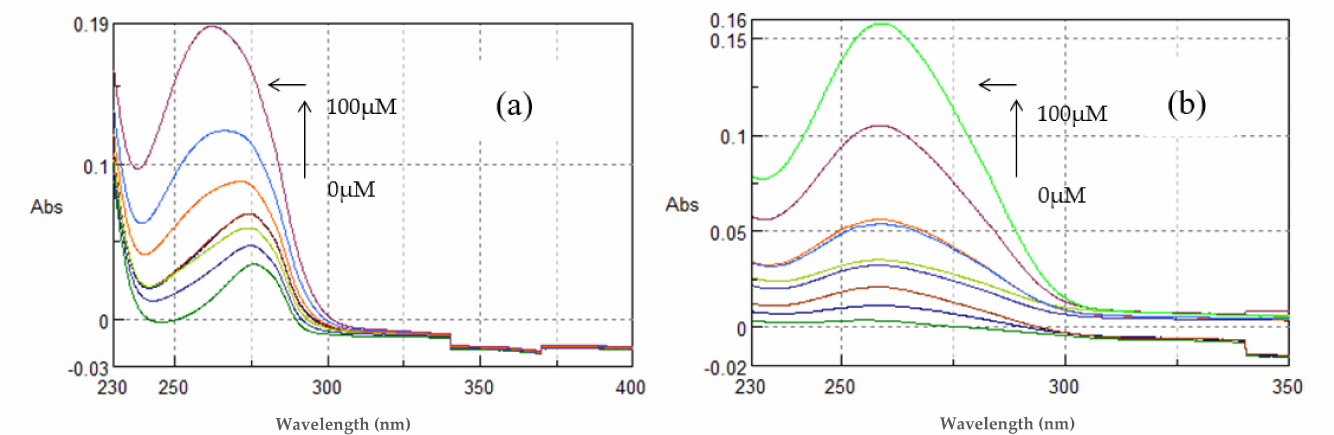
Figure 14. Absorption spectra of ( a ) TYR- β CD and ( b ) TYR- β CD/CS (100 µ M, pH 7.4) in Tris-HCl buffer with increasing concentrations of ctDNA (0–100 µ M). Arrows ( ) and ( ) refer to hyperchromic and hypsochromic (blue shift) effects